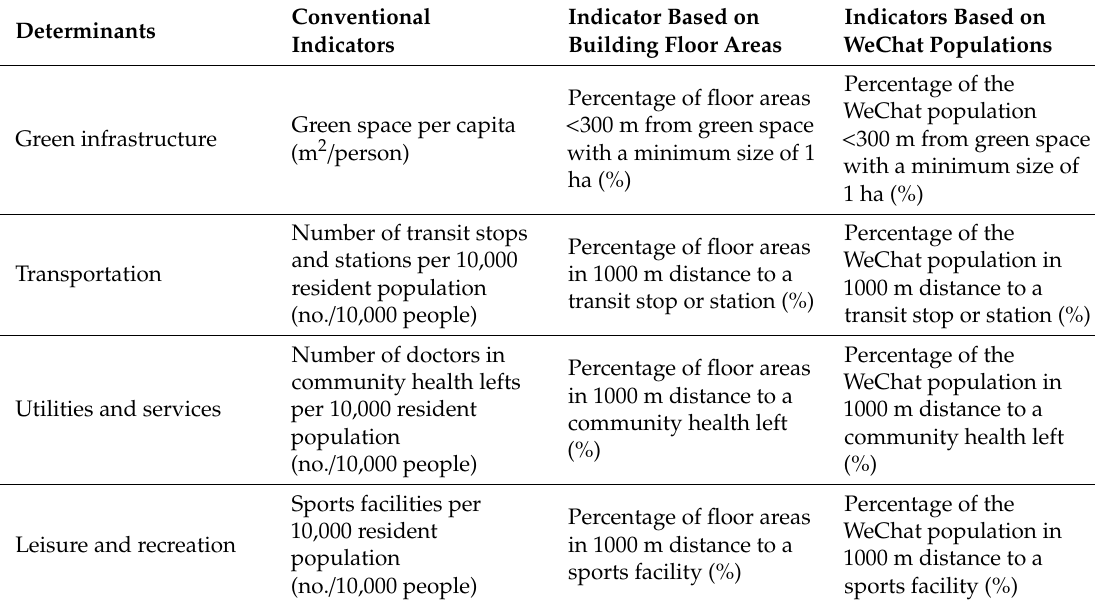
Table 1. Healthy City indicators and spatially explicit counterparts used in this study and the ways to calculate